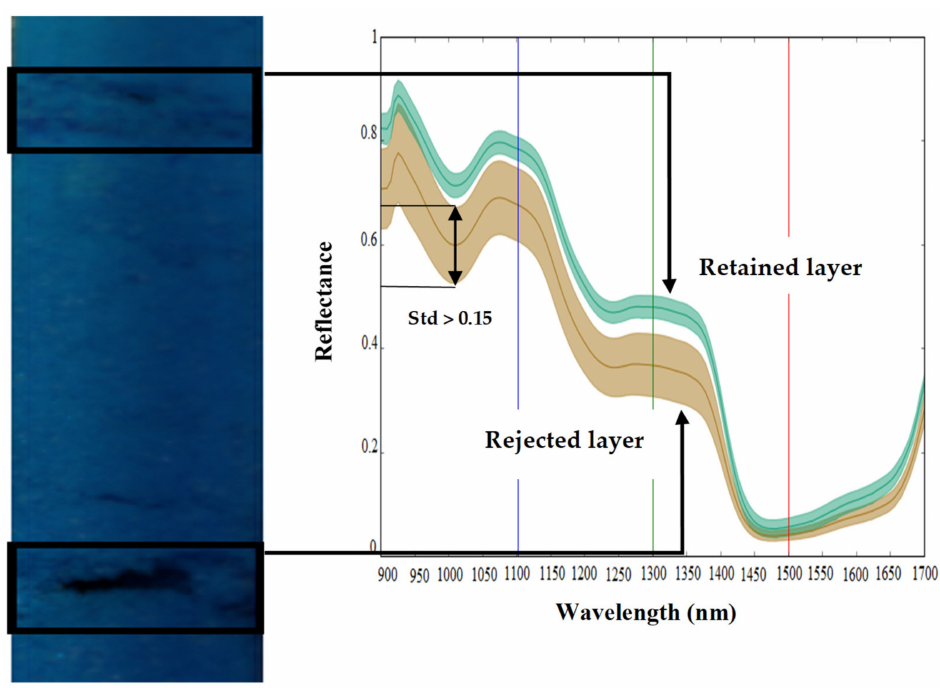
Figure 9. Snow layer retained (homogeneous), snow layer rejected (heterogeneous).